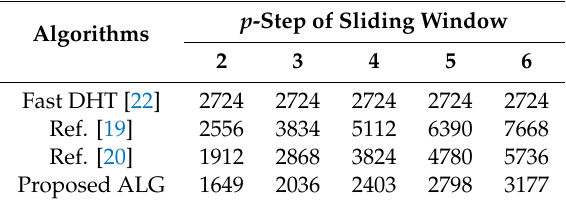
Table 4. Comparison of the tested algorithms in terms of flops for computing sliding DHT, N = 256.